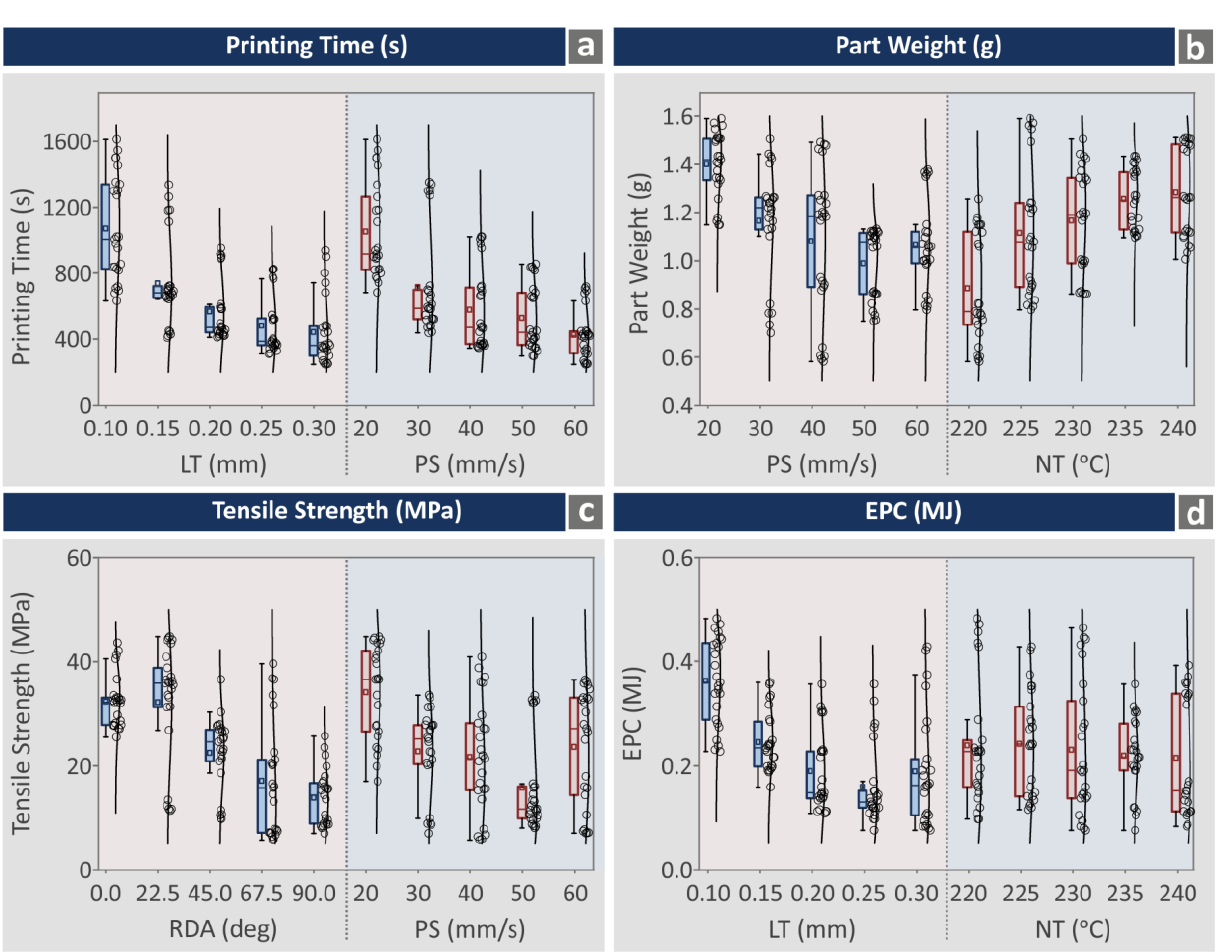
Figure 7. Boxplot graphs ( a ) printing time (s), ( b ) part weight (g), ( c ) tensile strength (MPa), and ( d ) EPC (MJ).